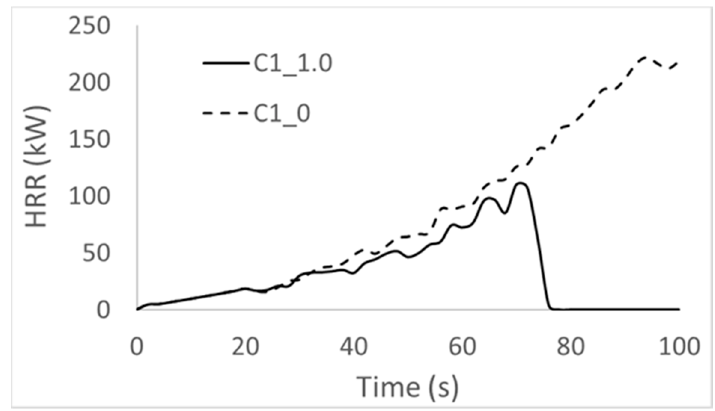
Figure 7. Heat release rates (HRRs) versus time for series case C1.